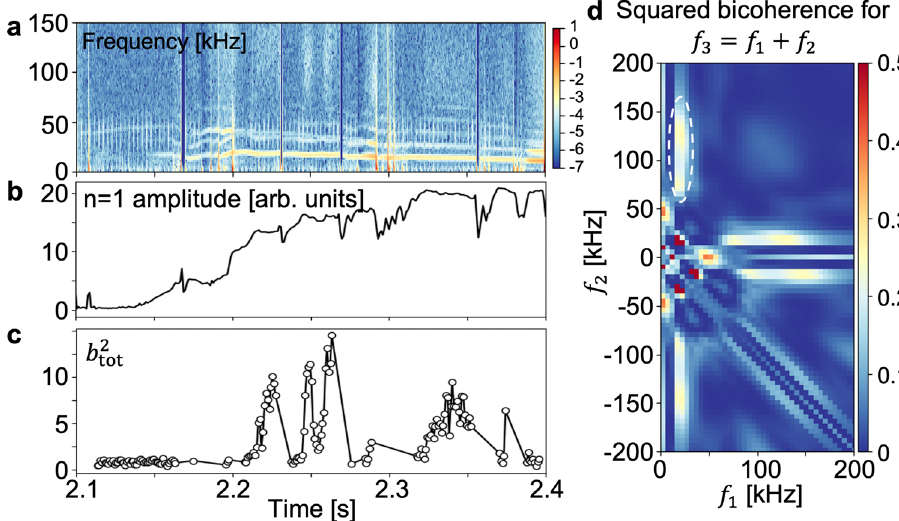
Fig. 6 Three-wave coupling between turbulence and the neoclassical tearing mode (NTM). a The power spectrogram of density fl uctuations. b The n = 1 mode amplitude. c The sum of the squared bicoherence ( b 2 ) in the white dashed oval in ( d ), meaning the nonlinear coupling strength among the NTM tot fl uctuation ( f f f fl uctuations for t = 2.2475 – 1 ) and density turbulence ( 2 and 3 ). d The squared bicoherence of density